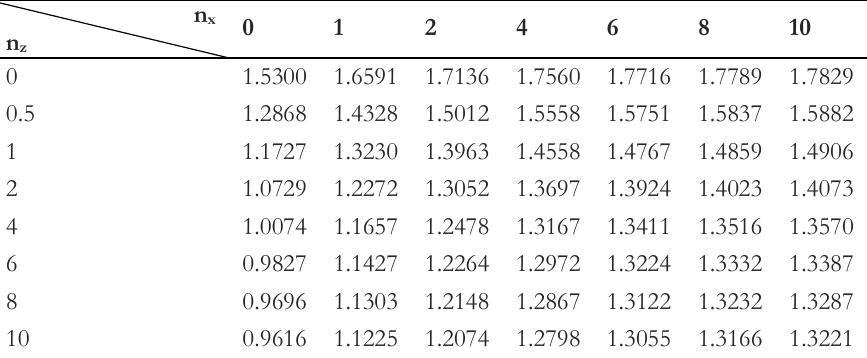
Table 7. The variation of non-dimensional natural frequency 𝛚̅ for a simply supported sandwich plate for various volume fraction exponents n x and n z